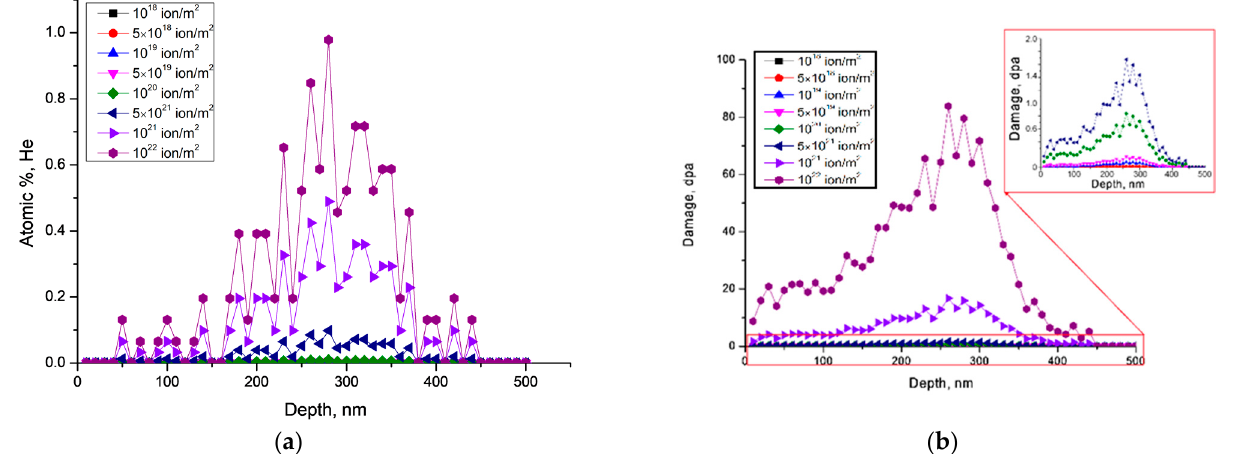
Figure 1. Simulation results in SRIM Pro 2013: ( a ) depth profile of He 2+ ion implantation as a result of irradiation; ( b ) displacements per atom (dpa) versus the depth (for different fluences).